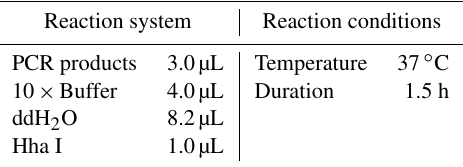
Table A1. System components and reaction conditions for enzyme digestion of CLPG PCR products.